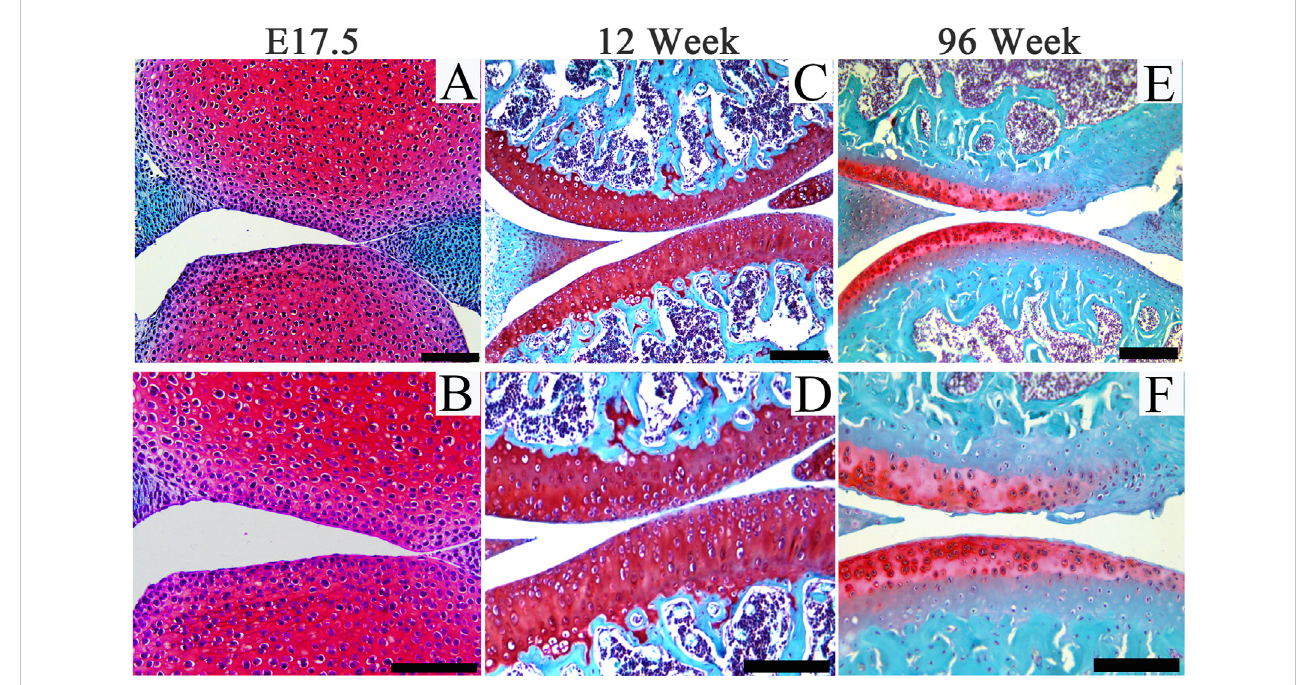
FIGURE 1 Representative images of Safranin O staining of articular cartilage of joints from embryos (E17.5), adult (12-week-old) and aging (96-week-old) mice. Scale bars = 200 μ m.